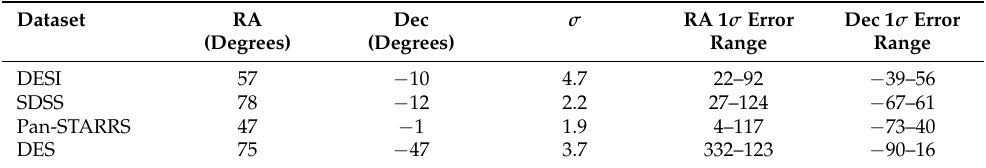
Table 7. The most likely dipole axes observed in the different datasets, and the 1 σ error range of the peak of the axes identified in each dataset.